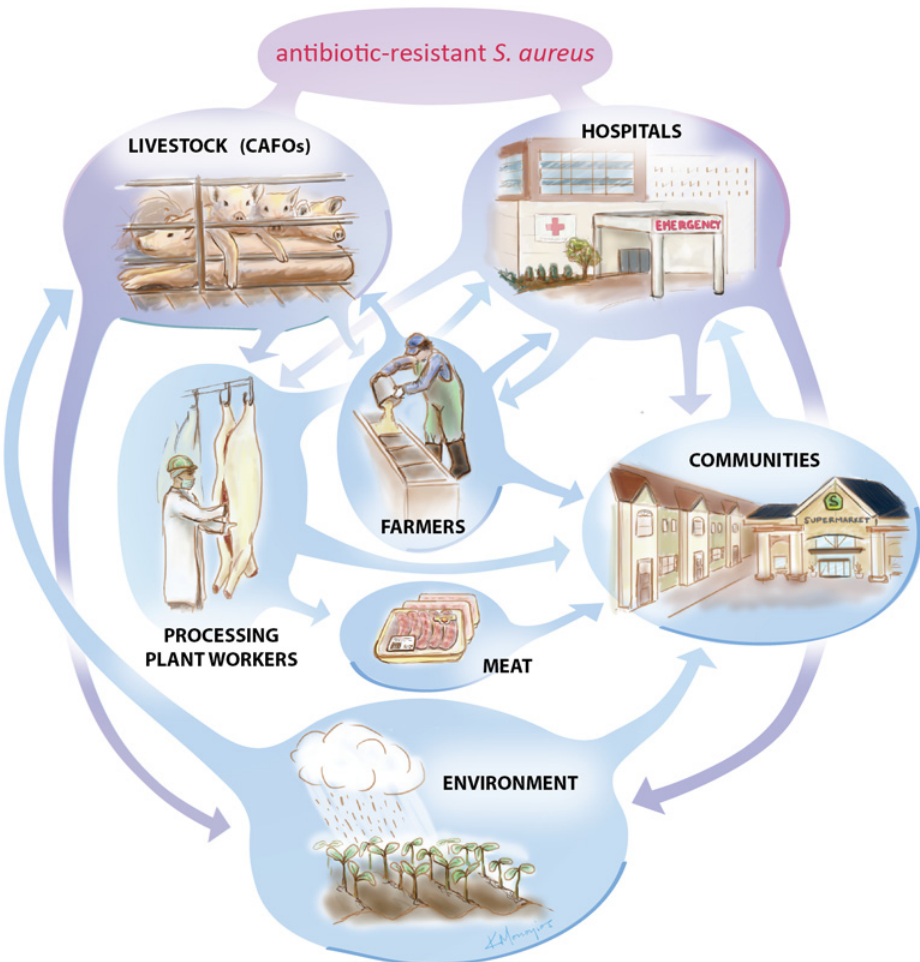
Figure 1. The tangled web of S. aureus in the US. Antibiotic-resistant Staphylococcus aureus is a growing public health concern, but tracing the origins of the bacterium is complicated. Evidence suggests that antibiotic-resistant strains of S. aureus can spread in livestock operations and hospitals where antibiotics are regularly used. These antibiotic-resistant organisms can then spread into communities and the environment. More research is needed to determine exactly how these transfers occur. Image by Kalliopi